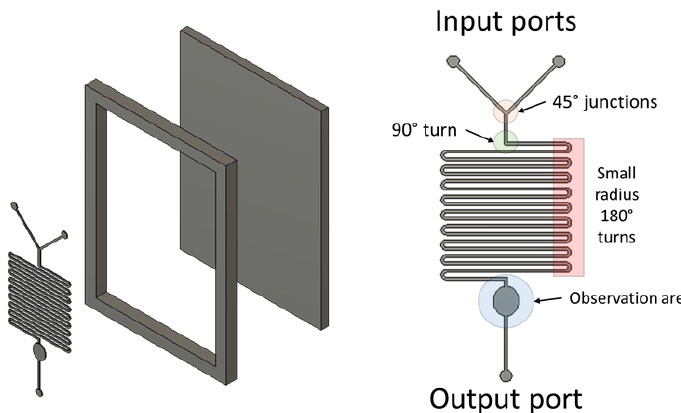
Figure A3. Exploded diagram of the 3D printed mould and device features.